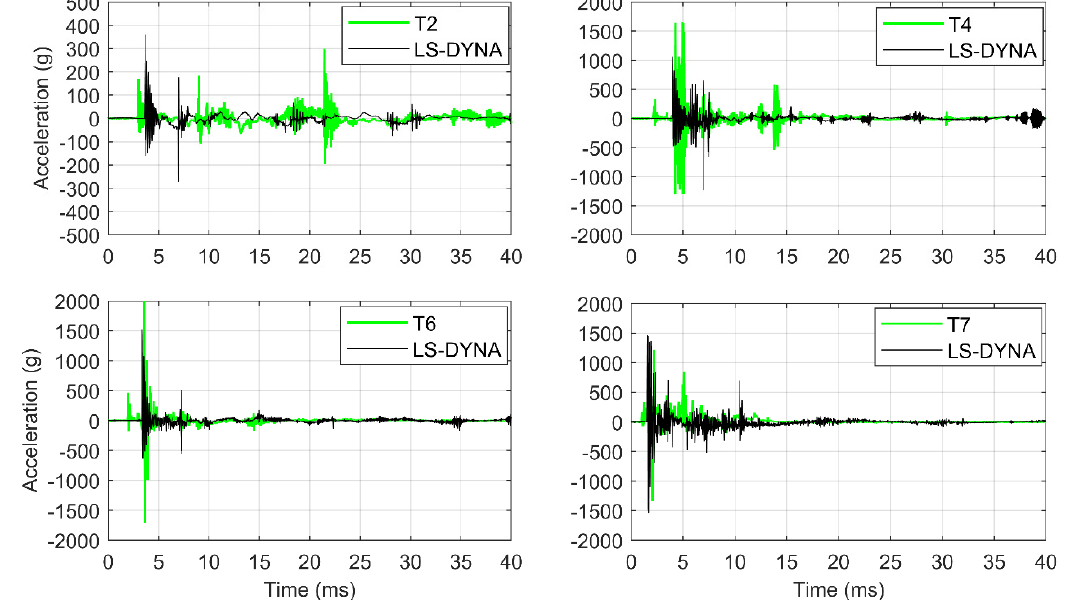
Figure 10. Accelerations from tests T2, T4, T6 and T7, in position A5 (see Figure 1) and their comparison with LS-DYNA.